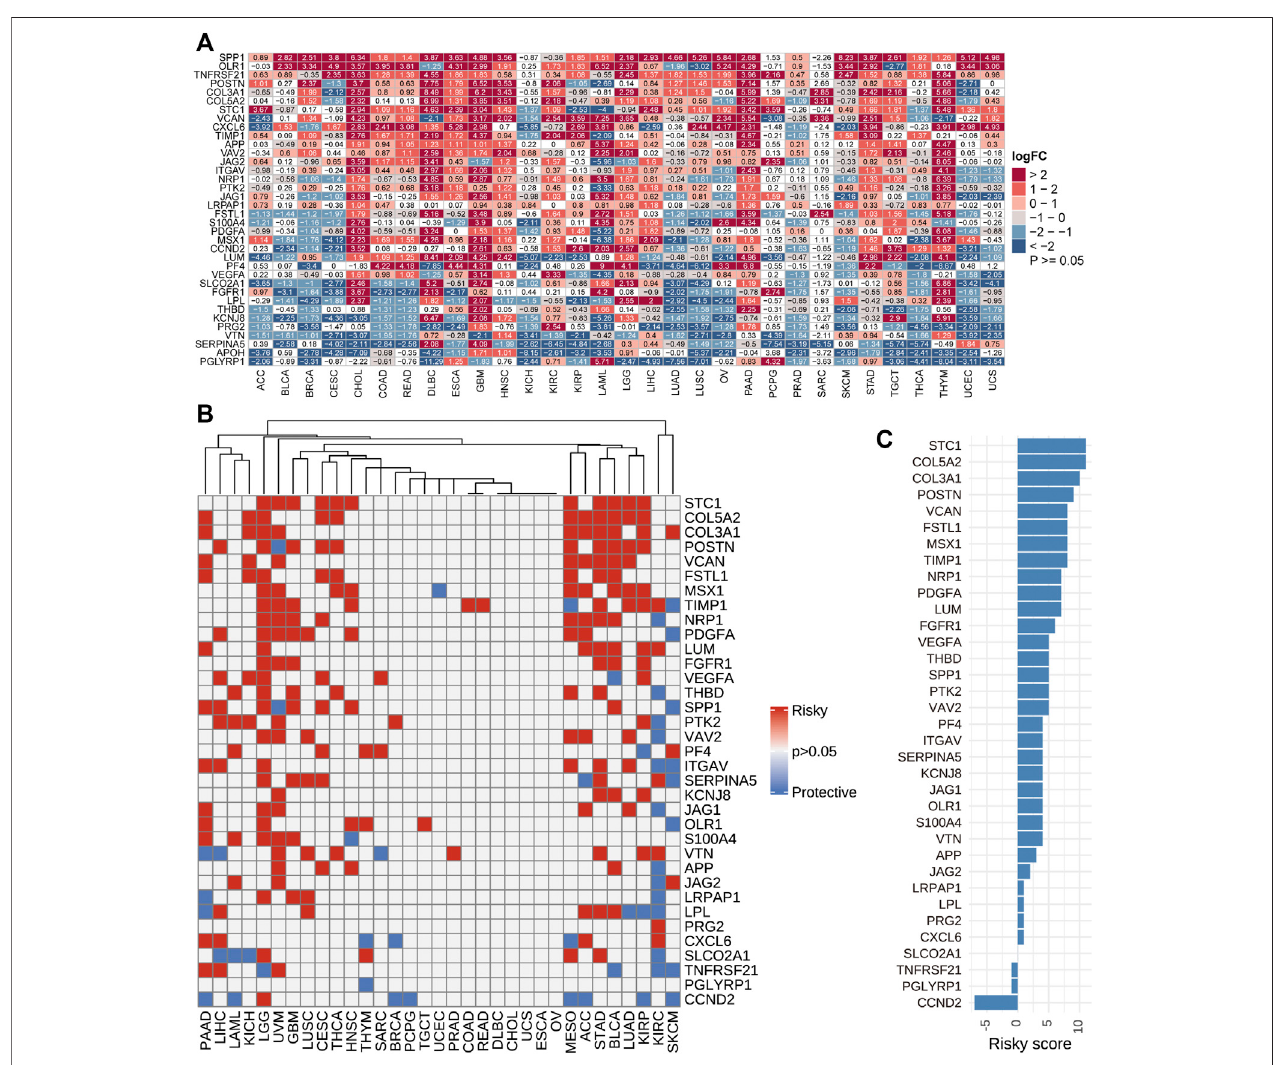
FIGURE 2 | (A) : Differential expressions of angiogenesis-related genes. We found the angiogenesis genes were aberrantly expressed in 31 tumor types. (B) . Univariate Cox regression analysis of angiogenesis-associated genes in pan-cancer. Grey denotes p > 0.05, red represents p < 0.05 HR > 1while blue denotes HR < 1 (C) . The number of genes with signi fi cant cox analysis in all tumors was counted. As a risk factor +1, as a protective factor -1, the fi nal score as risky score.